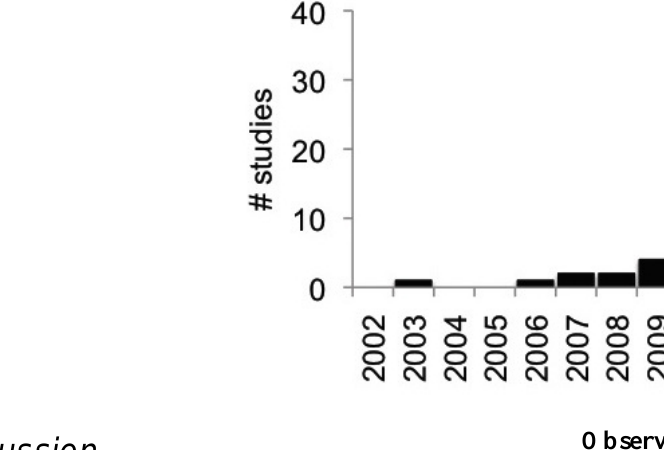
Figure 2. Number of studies meeting criteria for systematic review, by year (studies published through